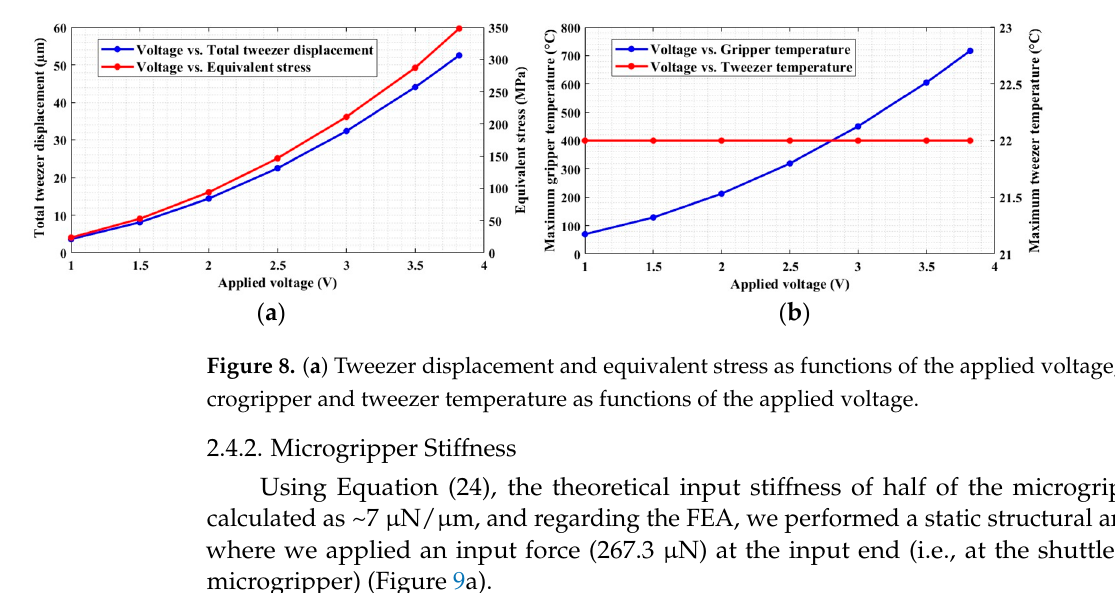
12 of 20 Figure 7. ( a ) Total displacement; ( b ) stress field when 39.16 µm input displacement is applied at the shuttle of the gripper. The output displacement of each tweezer resulted in a value of 52.5 µm (Figure 7a), i.e., the total output displacement of the tweezers was 105 µm, with a corresponding dis- placement amplification ratio of 2.68 (i.e., 105/39.16 µm). As shown in Figure 7b, the max- imum stress of the microgripper was ~283 MPa, which is considerably less than the yield strength of the material (7 GPa); therefore, the device can be used safely. By comparing the amplification ratio value obtained from the analytical modeling and simulations, there is a good match, with a relative difference of only ~1%, thus demon- strating the effectiveness of the PRBM approach in modeling the kinematics of the struc- ture under investigation. The small difference between the analytical and numerical esti- mation can be due to different reasons, such as (i) the linkages are considered as rigid links in the theoretical model, but deformation occurred on the linkages in FEA simula- tion, and (ii) the rotation center of the flexure hinges drifted in FEA simulation, while in the theoretical modeling this cannot happen. Figure 8 reports a plot showing the overall performance of the designed microgrip-